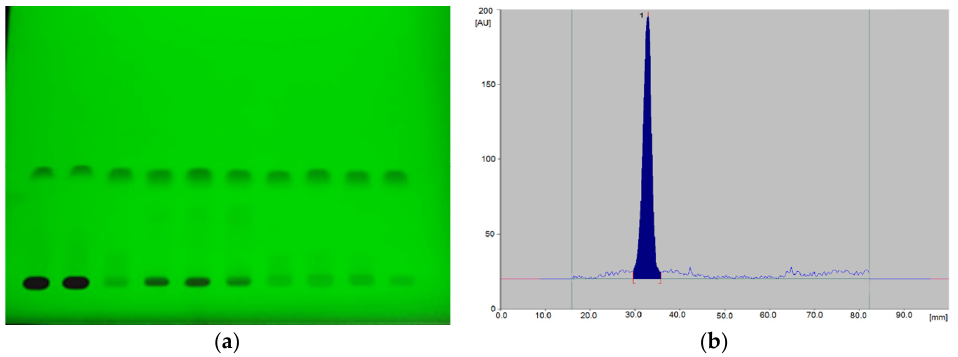
Figure 2. An example of the chromatogram ( a ) and densitogram ( b ), obtained for grapiprant solutions (at 254 nm).